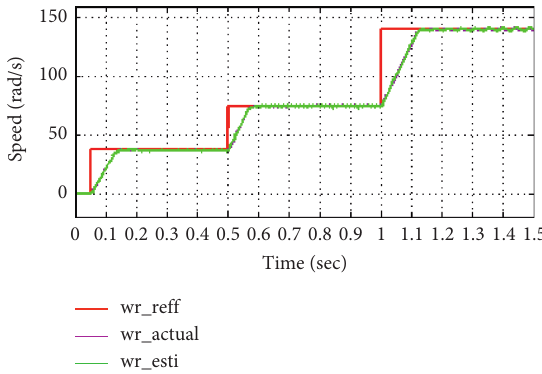
Figure 14: 75% decrease of all parameters from their nominal value for different rotor speeds with load torque.